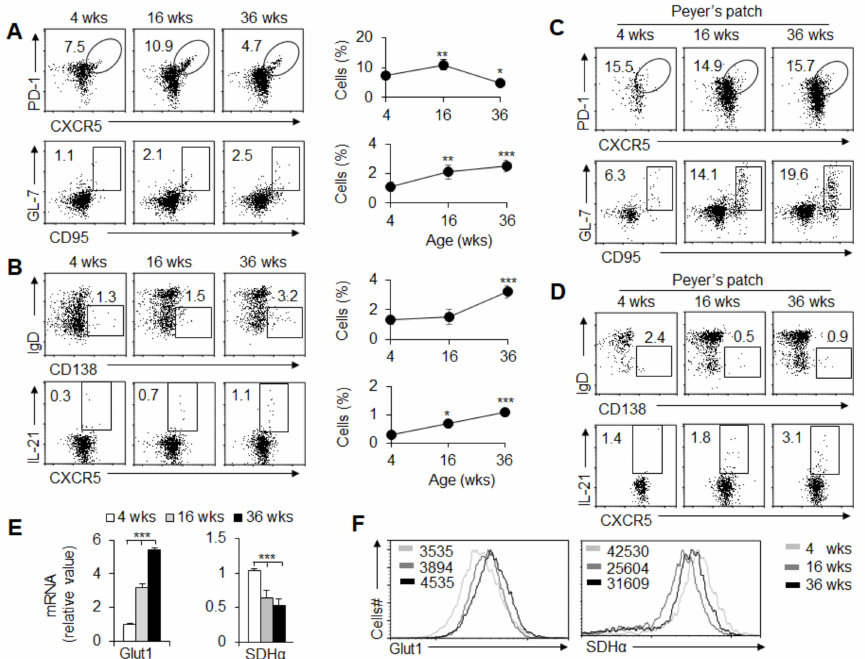
Figure 1. Age-related GC responses and T FH cell di ff erentiation. ( A ) Flow cytometry of T FH cells (CXCR5 + PD-1 + ) among CD4 + T cells and GC B cells (CD95 + GL-7 + ) among B220 + cells in spleens from wild-type (WT) mice at the ages of 4, 16, and 36 weeks. The right panel shows the frequency of T FH cells and GC B cells. ( B ) Flow cytometry of plasma cells (IgD - CD138 + ) among B220 + cells and IL-21 + T FH cells in spleens. The right panel shows the frequency of plasma cells and IL-21 + T FH cells. ( C ) Flow cytometry of T FH cells and GC B cells in Peyer’s patches (PPs) from WT mice at 4, 16, and 36 weeks of age. ( D ) Flow cytometry of plasma cells and IL-21 + T FH cells in PPs. ( E ) Glut1 and Sdh α mRNA expression was examined by real-time PCR analysis in T FH cells sorted from the splenocytes. ( F ) Flow cytometry of Glut1 and SDH α expression in T FH cells in spleens. Analyses of mean fluorescence intensity (MFI) are shown. Data are representative of three individual experiments (n = 3–6 mice per group). * p < 0.05; ** p < 0.01; *** p < 0.001, compared with the indicated